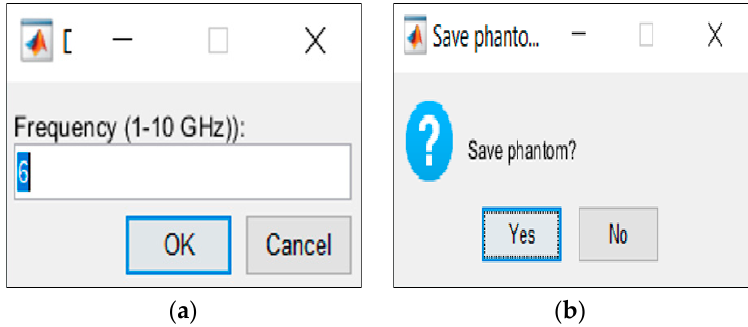
Figure 8. Stage 3 interfaces. ( a ) Generator interface which allow the users to choose the frequency value at which the phantom generator should interpolate the dielectric properties values of the biological tissues for a given frequency. ( b ) Interface which allows the user to save the phantom.